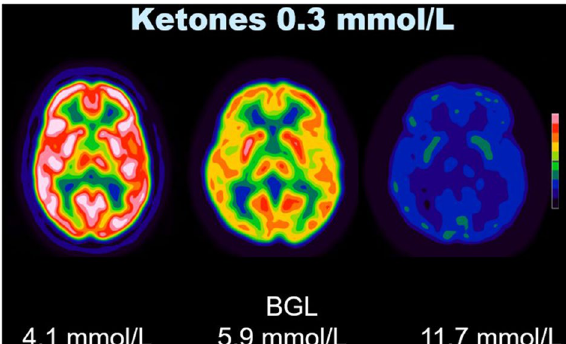
Fig. 1 Effect of BGL on cerebral SUVbw. Sample images of three patients thresholded identically with the same serum ketone level, but different BGLs illustrate the sometimes dramatic reduction in FDG uptake in